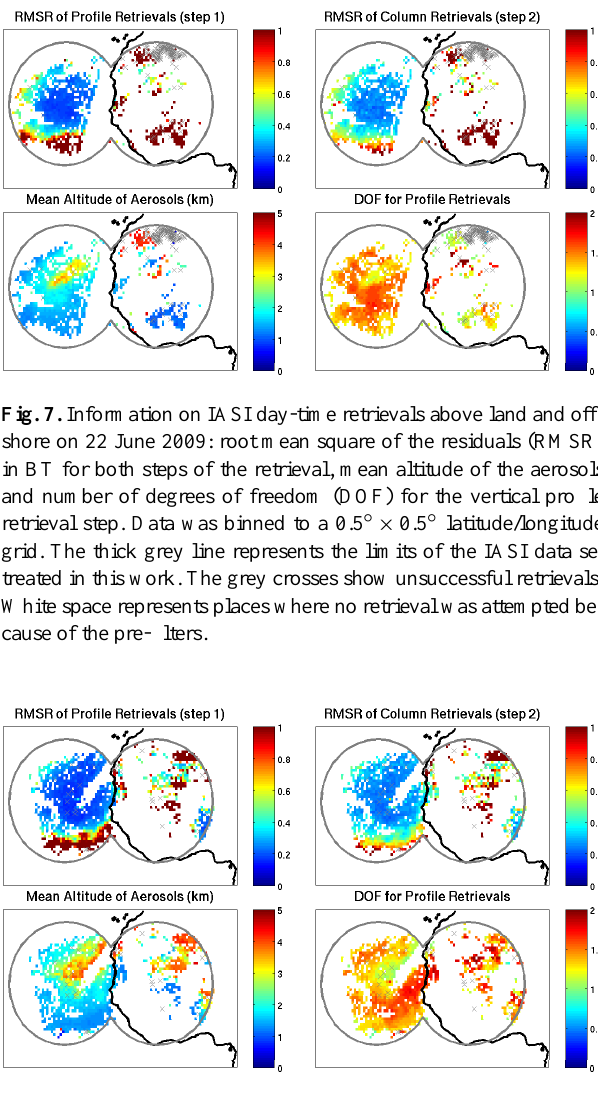
Fig. 8. Same as Fig. 7 for night-time